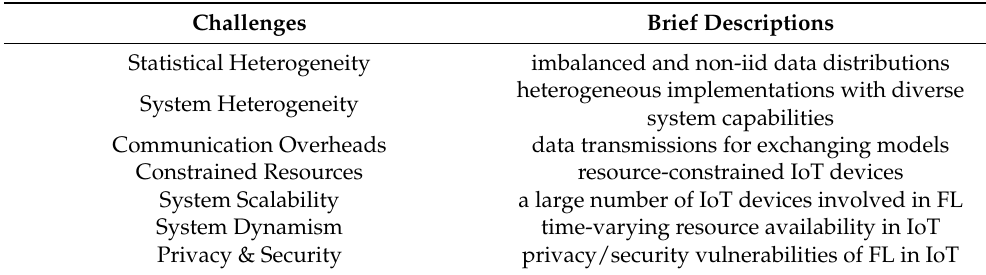
Table 1. A summary of the main challenges to federated learning in